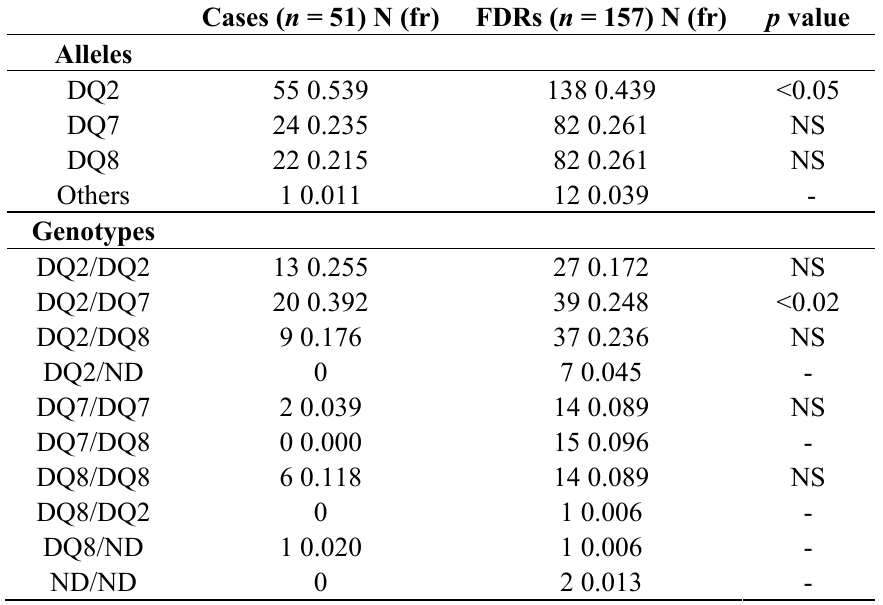
Table 5. Alleles and genotype frequencies in 51 celiac cases and 157 tTG first-degree relatives